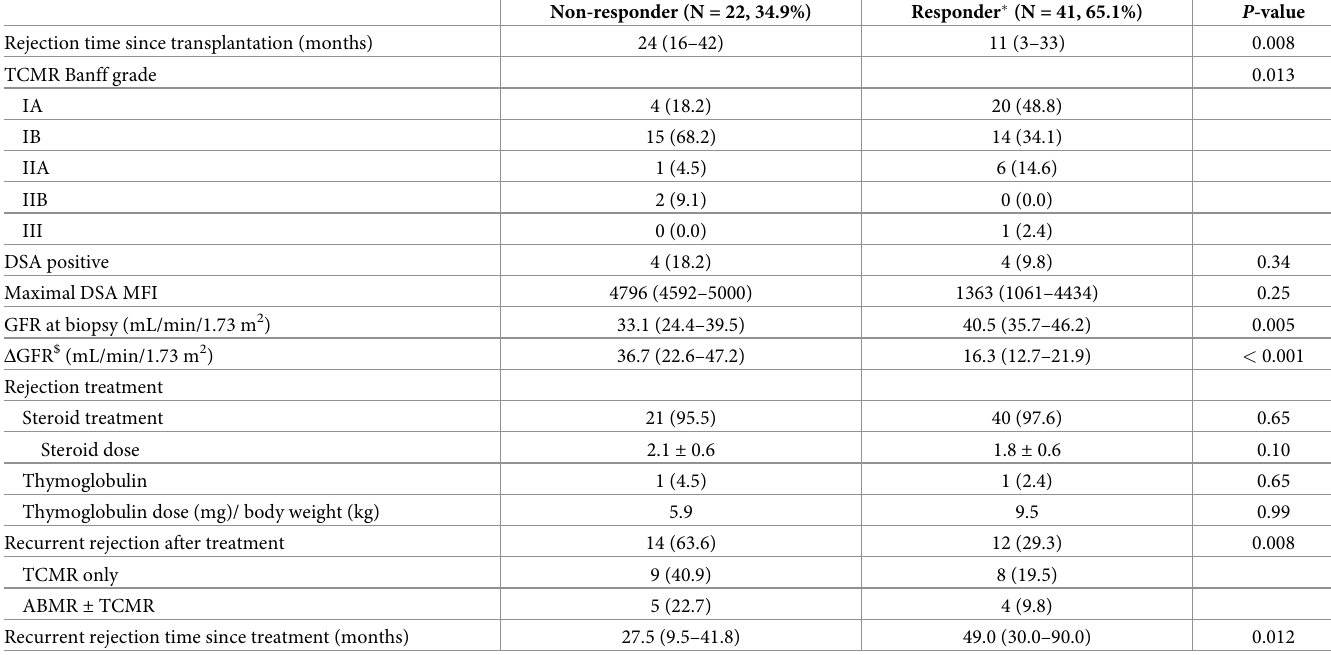
Table 2. Clinical characteristics at the time of acute T cell-mediated rejection.